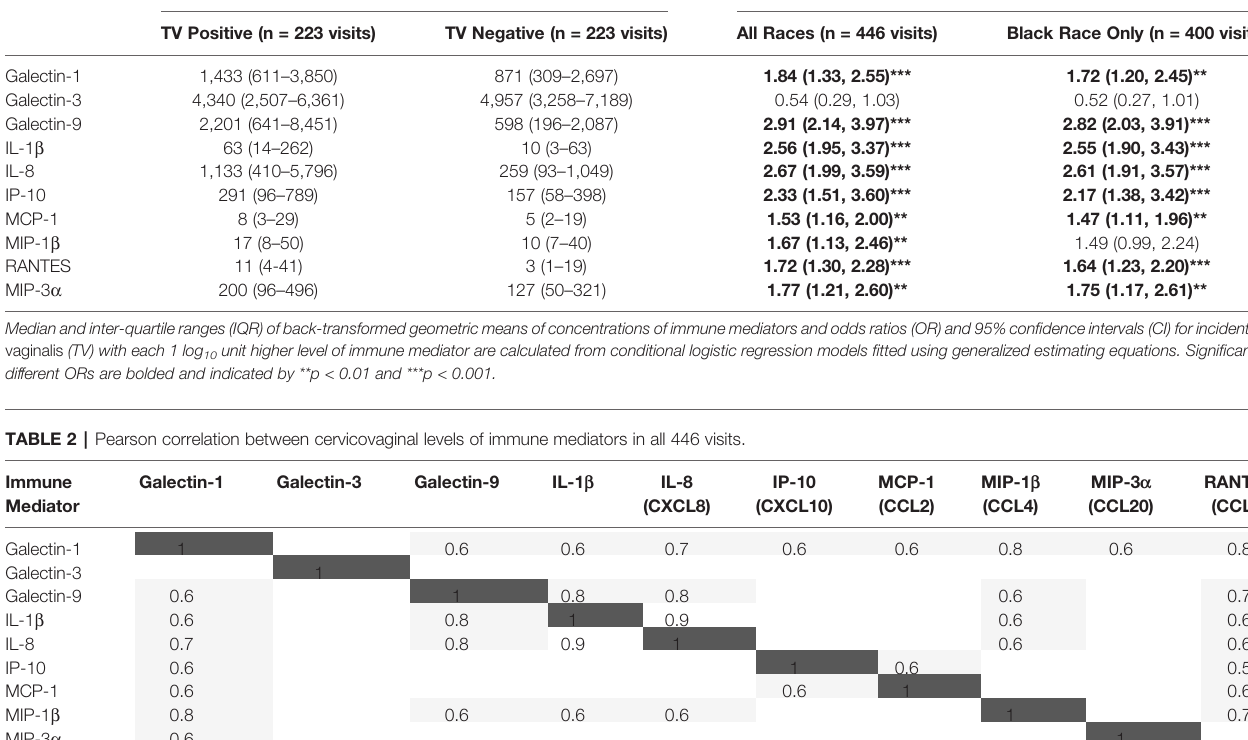
TABLE 1 | Association between TV positive status and cervicovaginal levels of immune mediators assessed in 223 case and 223 control visits. Biomarker Median (IQR) of geometric means in pg/ml